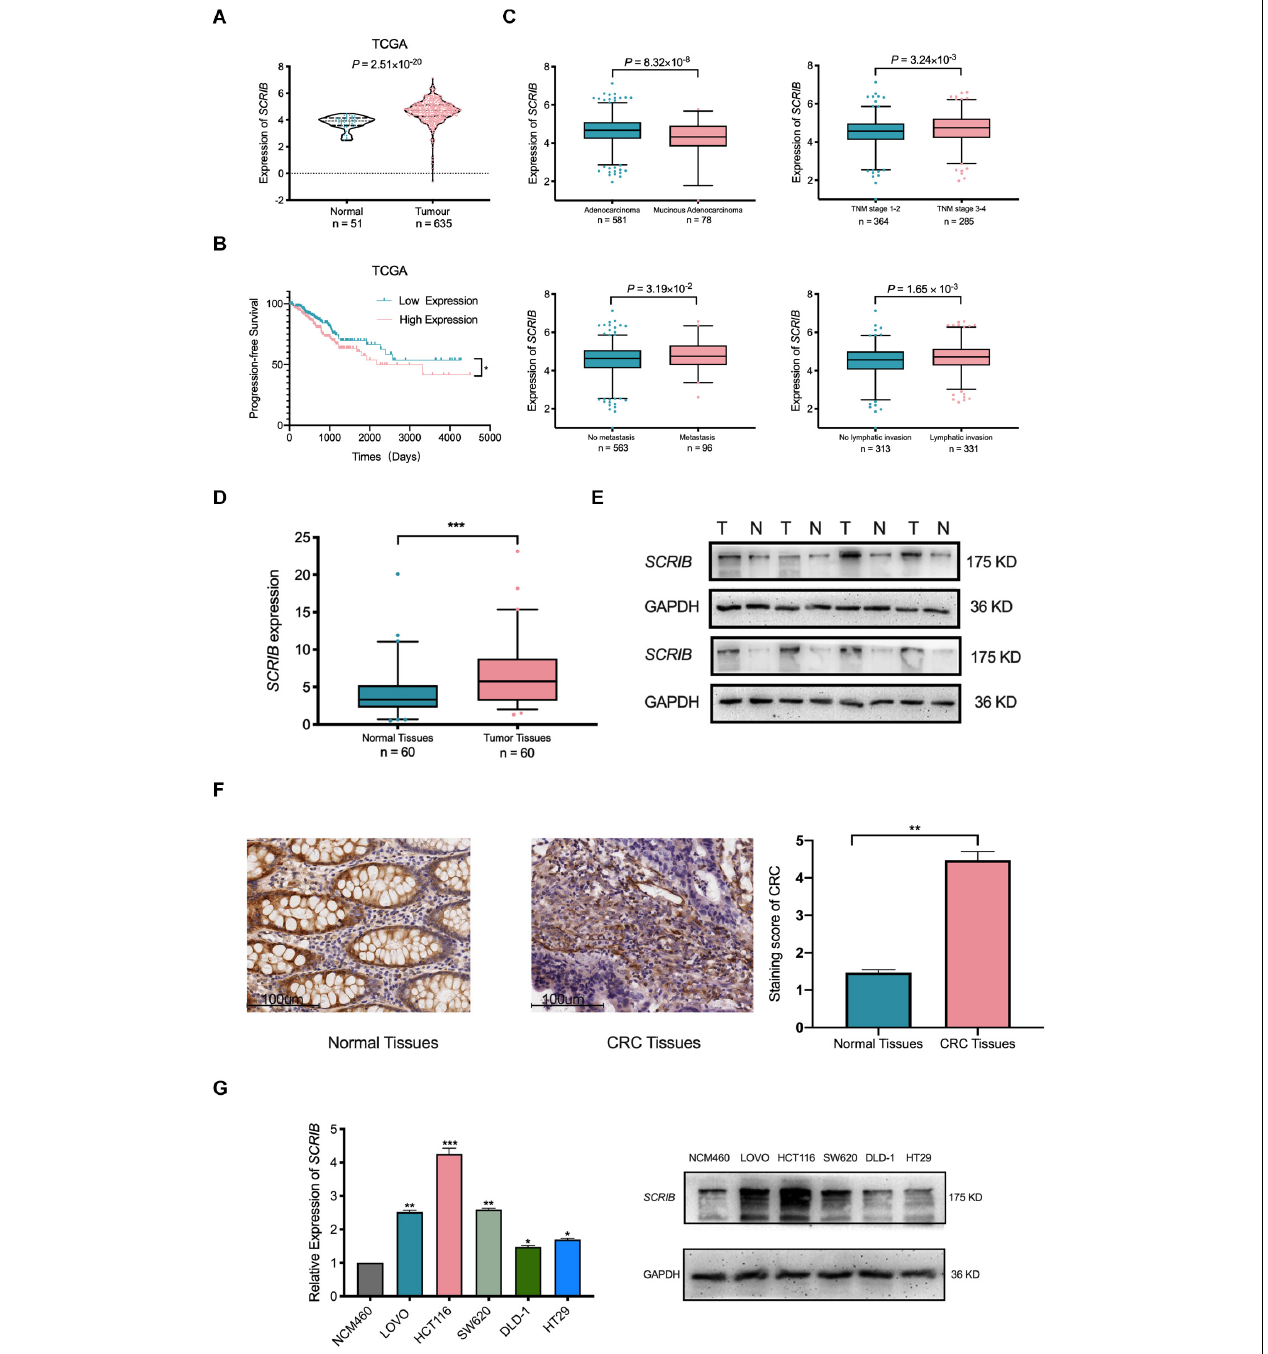
FIGURE 1 | Upregulation of SCRIB predicts poor prognosis for patients with colorectal cancer. (A) The expression level of SCRIB in normal tissues ( n = 51) and CRC tissues ( n = 635) from The Cancer Genome Atlas (TCGA) database. (B) CRC patients ( n = 499) with progression-free survival data in the TCGA database were included in the survival analysis. The population was divided into two groups according to the median expression level of SCRIB . (C) The stratified analysis of CRC patients was based on pathological type, stage, metastasis, and lymphatic invasion. The data were derived from TCGA. Due to the lack of patient data, the total number of stratified analyses is not consistent. (D) SCRIB expression in 60 paired CRC tissues and adjacent normal tissues. (E) The expression of SCRIB in eight pairs of CRC tissues (T) and adjacent normal tissues (N) was detected by western blot. (F) The expression of SCRIB in CRC tissue was assessed by immunohistochemical staining. Representative micrographs show high-level and low-level expression of SCRIB in tumour tissues and adjacent nontumorous tissues. Scale bar, 100 µ m. (G) qRT-PCR showed the expression level of SCRIB in NCM460, LOVO, HCT116, SW620, DLD-1, and HT29 cells; western blot showed the protein level of SCRIB in these cell lines. * p < 0.05, ** p < 0.01, and *** p < 0.001.